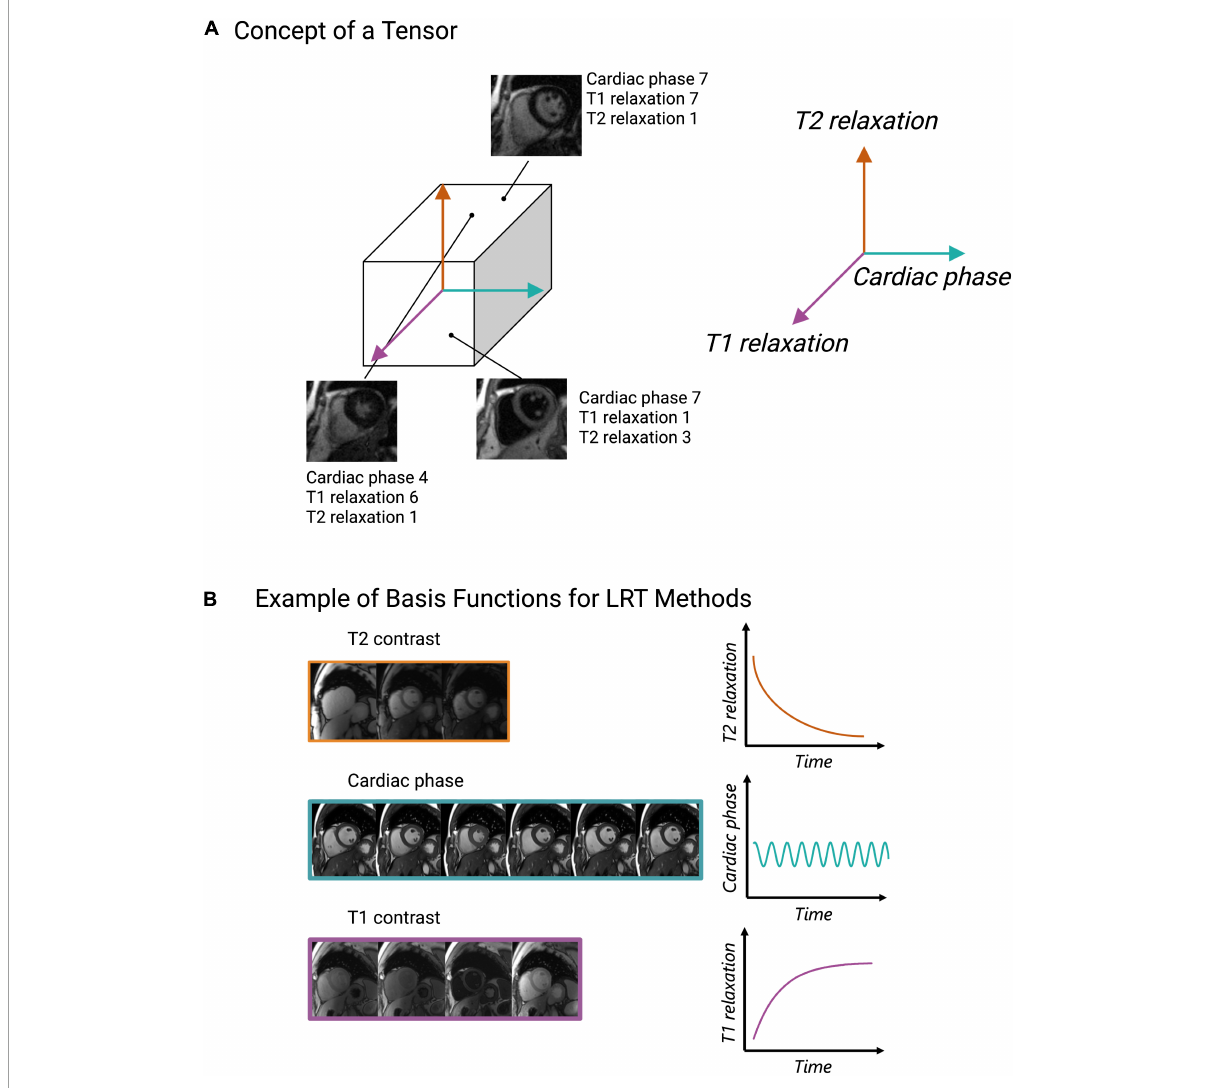
FIGURE5 Depiction of the low rank tensor (LRT) concept. (A) Example of CMR images represented as a tensor with cardiac phase, T1 relaxation, and T2 relaxation representing different dimensions of the tensor. Once CMR data is organized in this way, any coordinate along the tensor will obtain an image with a various cardiac phase, T1 and T2 relaxation time. (B) Pictorial example of basis functions, which capture the signal behavior of each dimension (cardiac, T1 relaxation or T2 relaxation). These basis functions allow CMR data to be undersampled and for missing data to be recovered through various linear combinations of the sampled